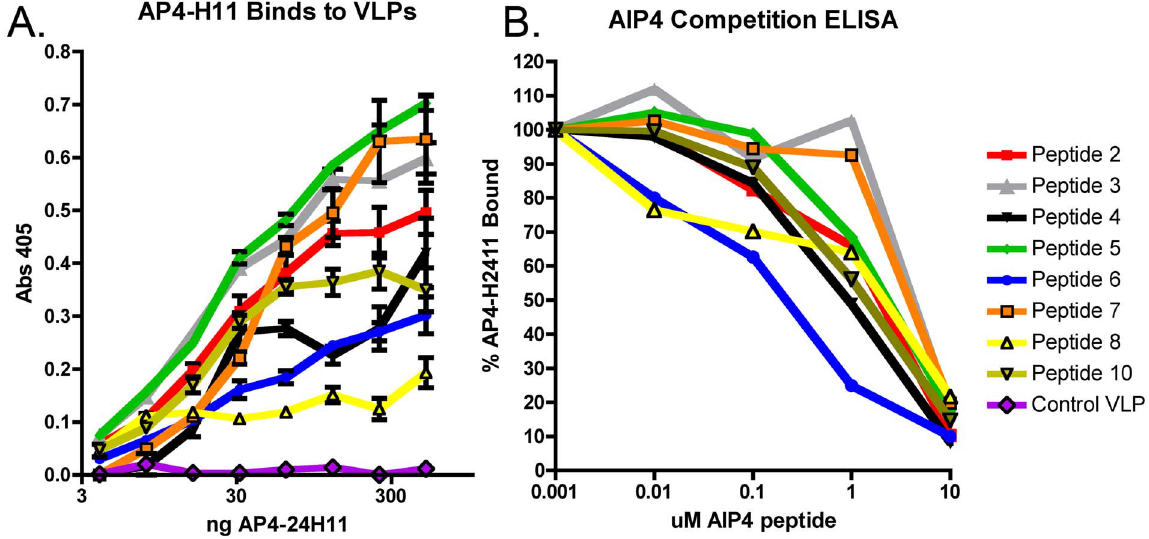
Figure 2. Affinity selected VLPs bind to and occupy the antigen binding site of mAb AP4 - 24H11. (A) ELISA was used to assess specific binding of VLP selectants to AP4-24H11. Wells were coated with the indicted VLPs and different concentrations of AP4-24H11 were applied. Error bars represent standard error of the mean. (B) For competition ELISAs, wells were coated with the indicated VLPs and AP4-24H11 was mixed with different concentration of the cyclical, bioactive AIP4 peptide prior to incubation with VLPs. Secondary antibody and detection was the same as above. As a control peptide, we used a linear form of AIP4. Results are representative of an experiment performed twice.